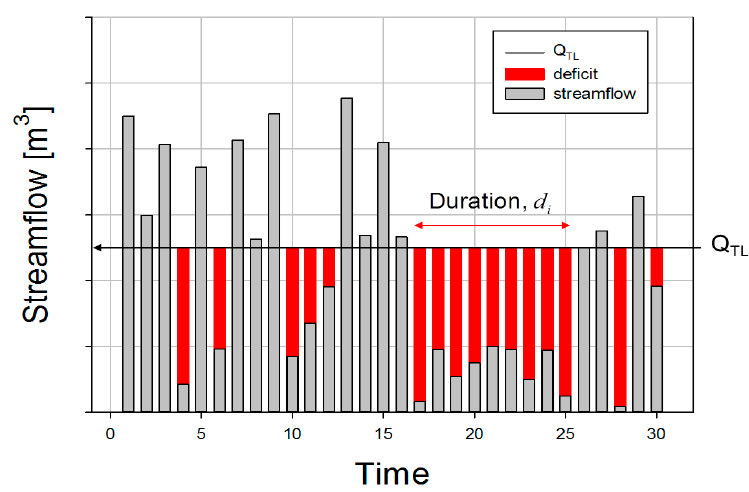
Figure 5. Definition of streamflow drought and deficit based on the threshold level method.